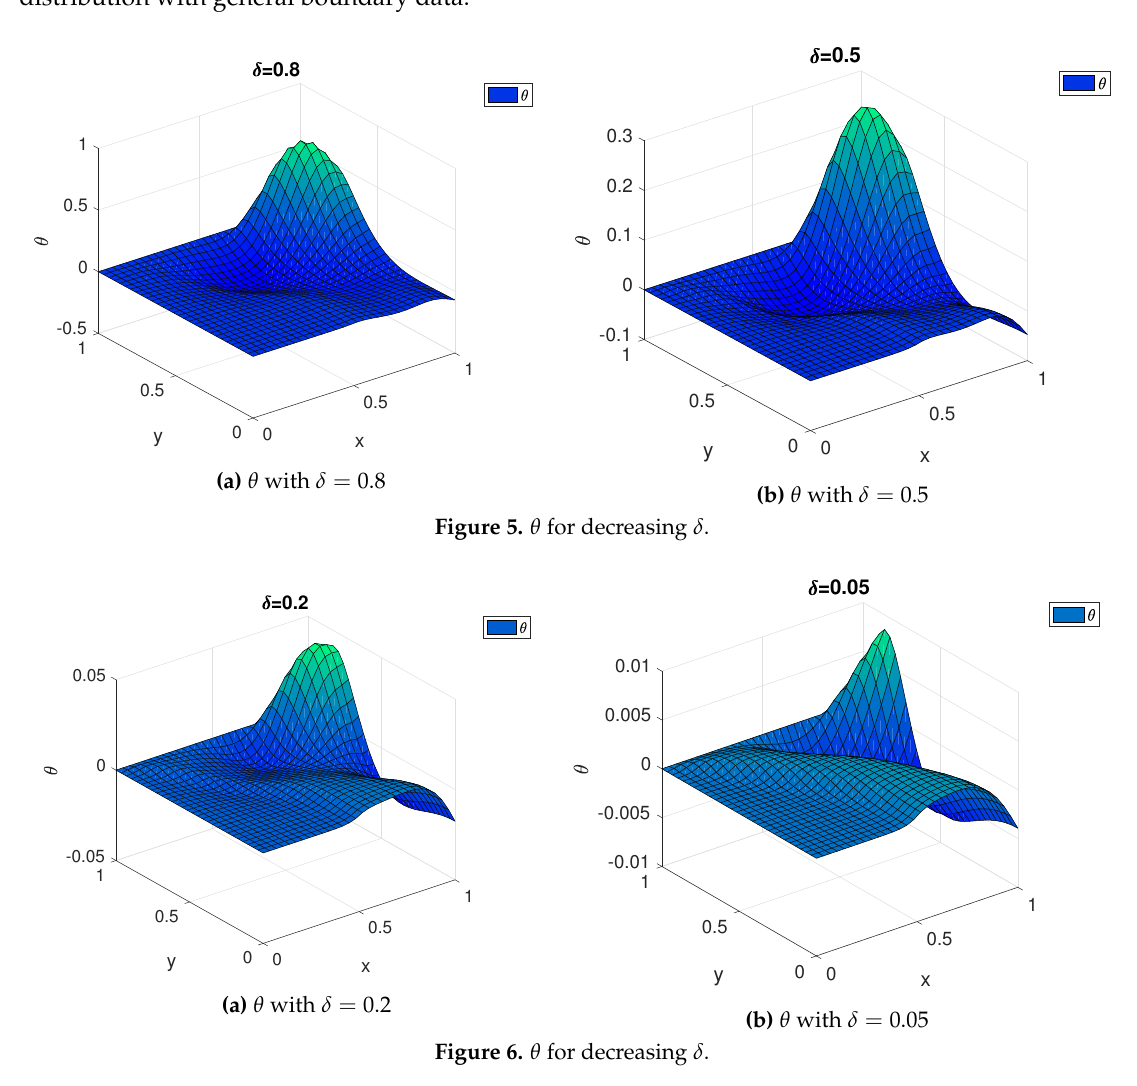
Figure 6. θ for decreasing δ